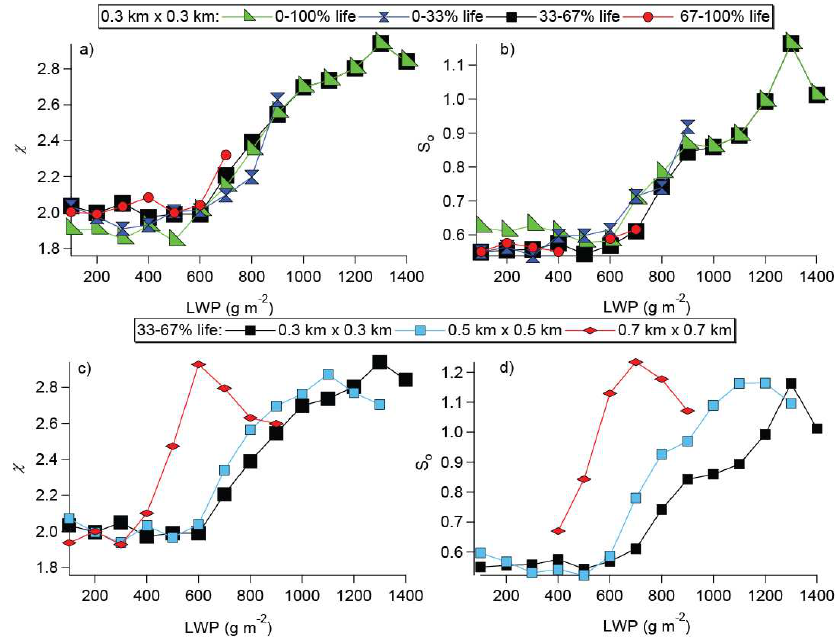
645 Figure 1. Large eddy simulation analysis of the effect of cloud lifetime on the quantification of 646 ¶ Nr lnln - (= ACI with N ( a ) LWPde ¶ of 800 g m -2 . The metric values are taken as slopes of the best fit lines. These data represent 648 values quantified at a spatial resolution of 0.3 x 0.3 km resolution. 649